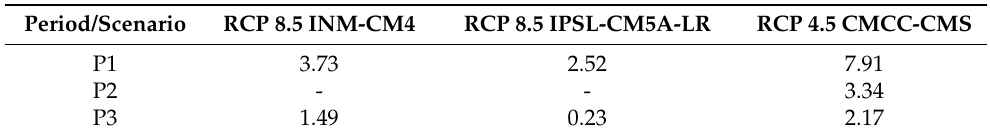
Table 12. Volume of water secured in the emergency storage (MCM) for Case 1, 2, and 3 in the Gunwi